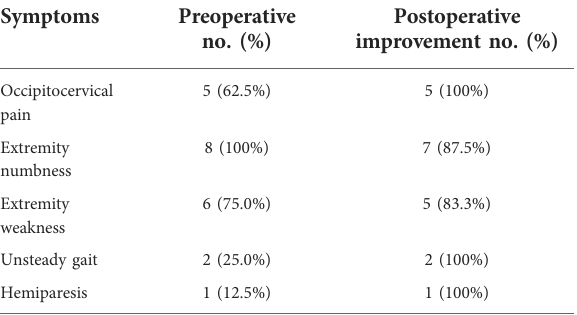
TABLE 2 Clinical